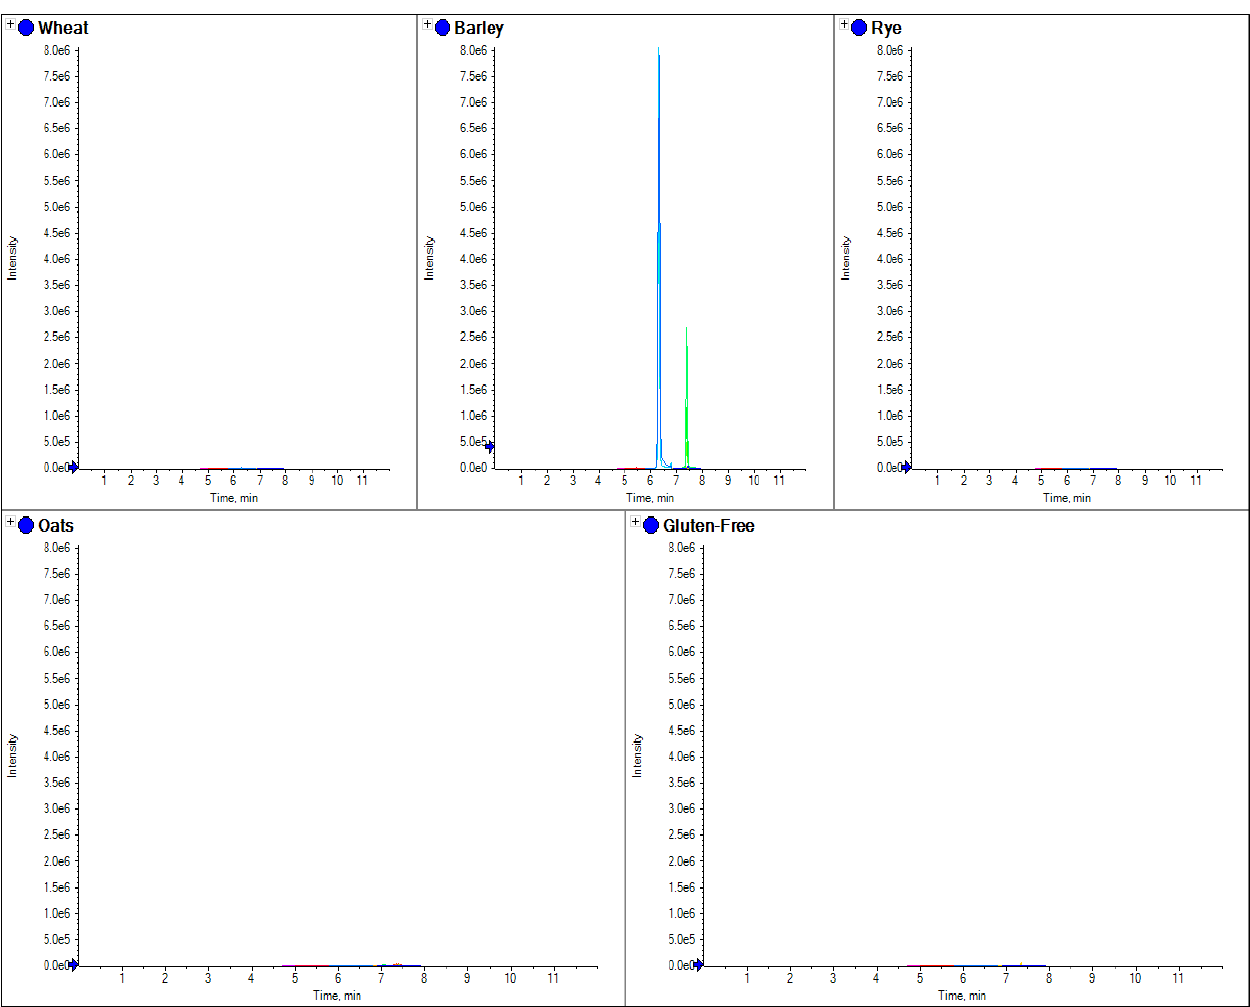
Figure 4. The comparison of separate extracts from barley, wheat, rye and oats flour. Here the overlaid chromatograms for barley marker peptides (obtained from the theoretical digestion of hordein) have been shown for flour extracts for each